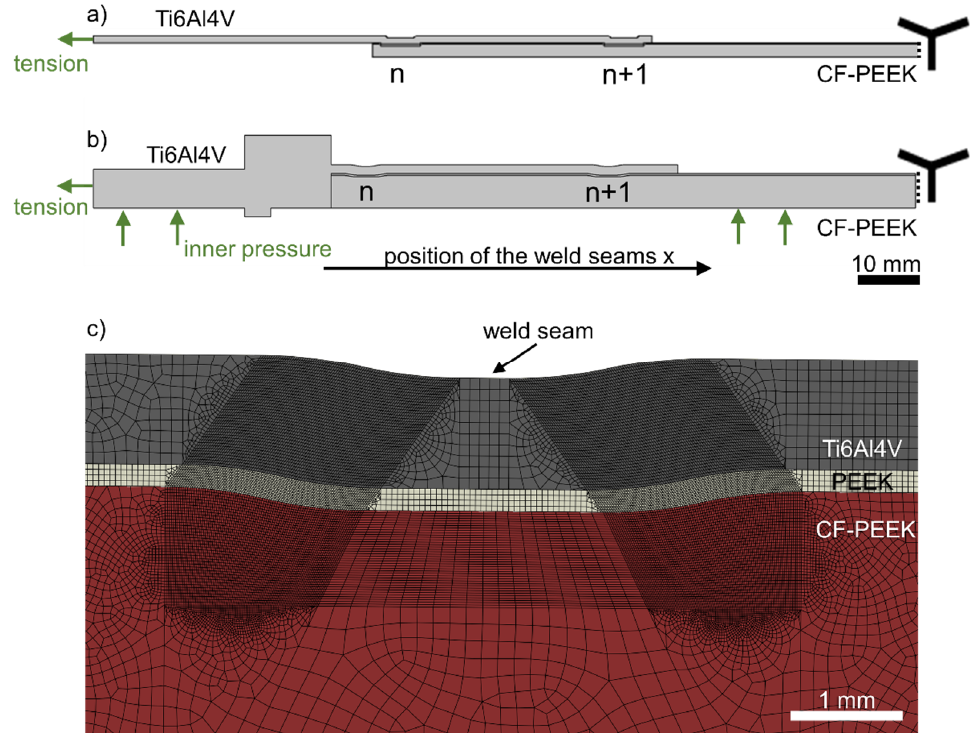
Figure 7. Finite element (FE) models of ( a ) Ti6Al4V-fitting/CF-PEEK-tube, ( b ) Ti6Al4V/PEEK/CF- PEEK sheet joint and ( c ) cross section of the weld seam.